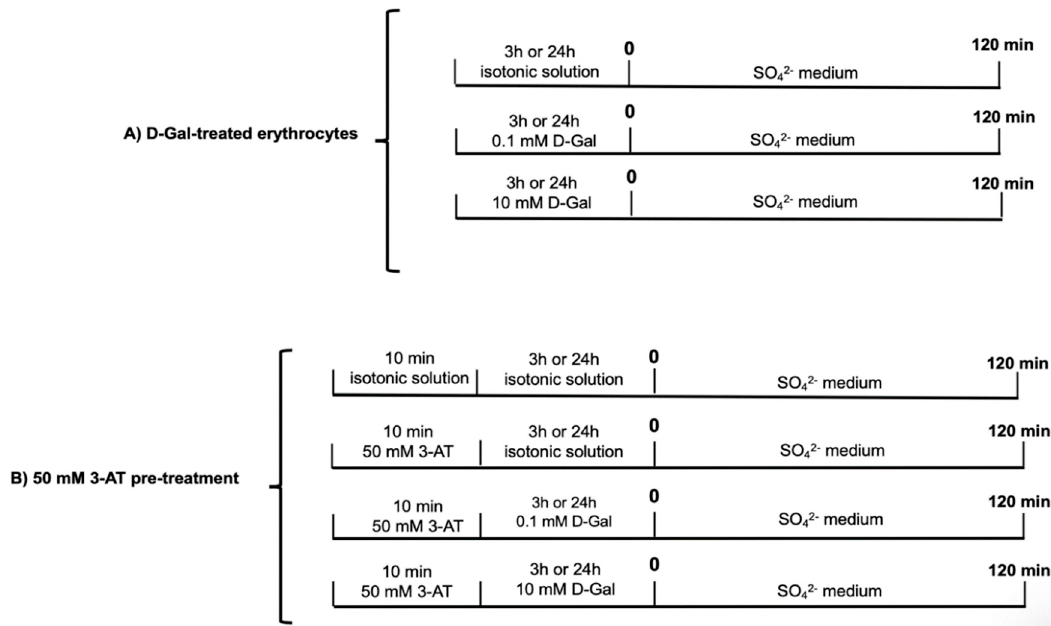
Figure 1. Time course of di ff erent experimental conditions before SO 42 − uptake measurement. ( A ) Gal-treated erythrocytes (0.1 or 10 mM, for 3 or 24 h). ( B ) 50 mM 3-AT pretreatment (10 min) plus Gal- treatment.